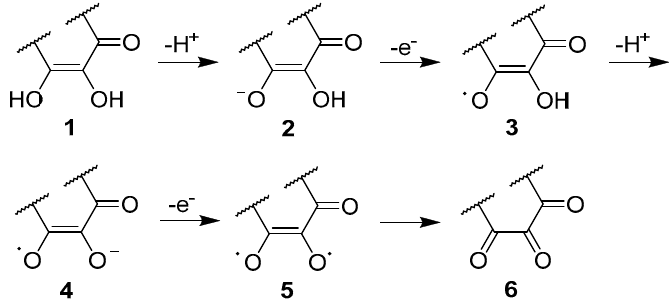
Figure 2. Mechanism for the ionization and oxidation of VC , 1 , to inactive dehydroascorbic acid, 6 . Partial structures are shown.